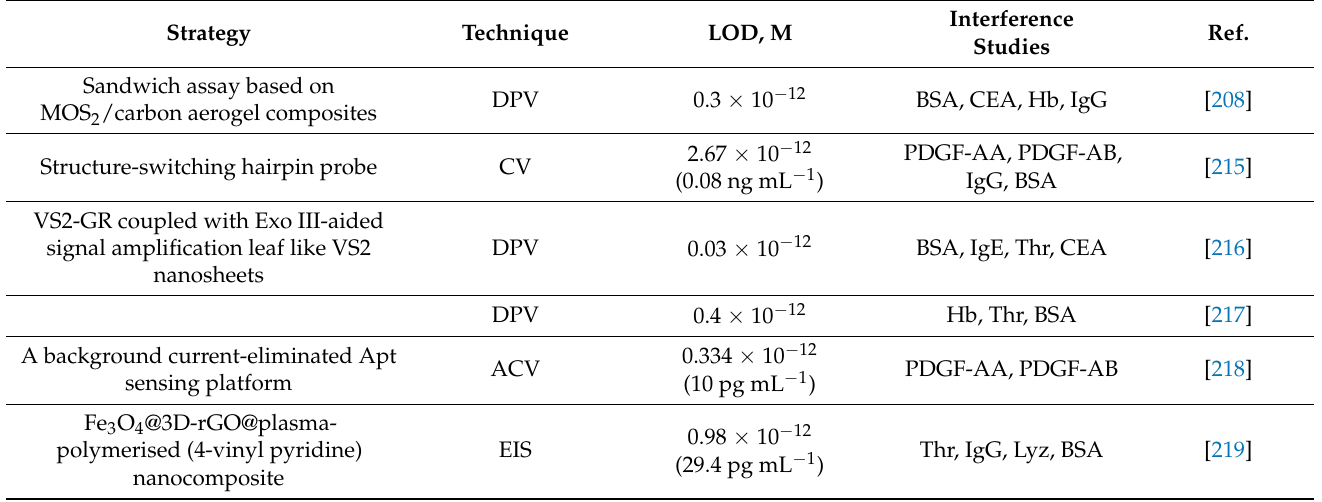
Table 4. Analytical performance of selected electrochemical aptasensors for